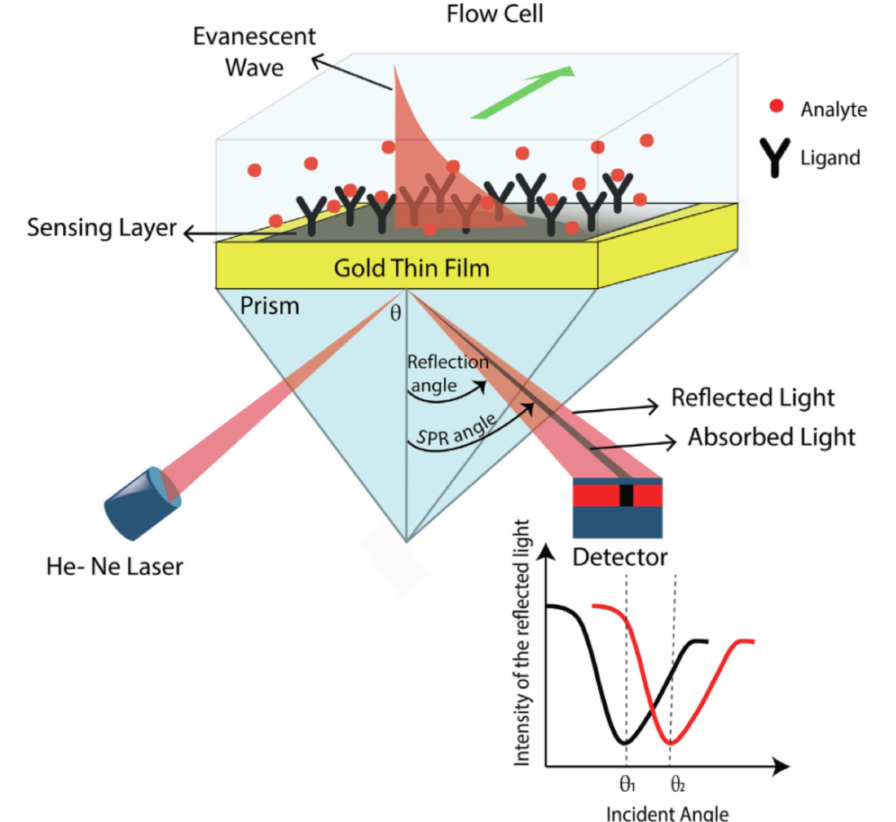
Figure 32. Surface plasmon resonance sensor setup. Reprinted from [106]. Copyright 2021 with permission from